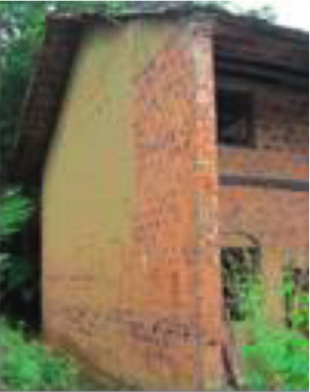
Figure 2: Mixed masonry method.